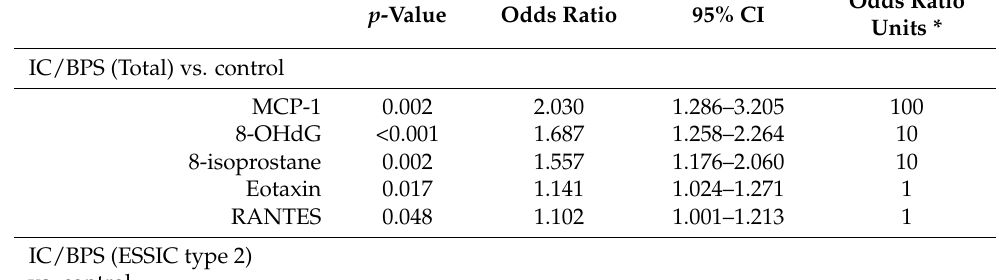
Table 5. Multivariate models (adjusting for age, gender, BMI, and DM), revealing the diagnostic values of targeted urine biomarkers. p -Value Odds Ratio 95% CI IC/BPS (Total) vs. control MCP-1 0.002